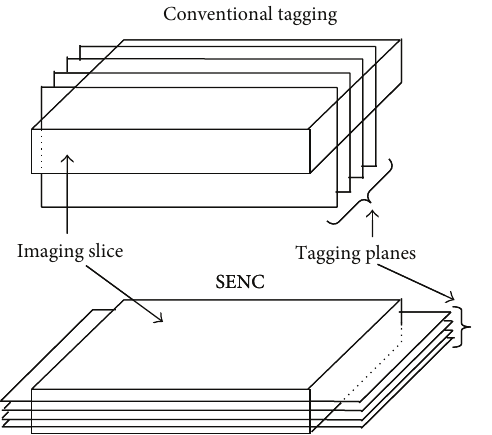
Figure 3: SENC imaging. SENC uses tagging as in conventional tagging. However, the tag planes are applied parallel to, and lie inside, the imaging slice; thus through-plane strain is measured in SENC.